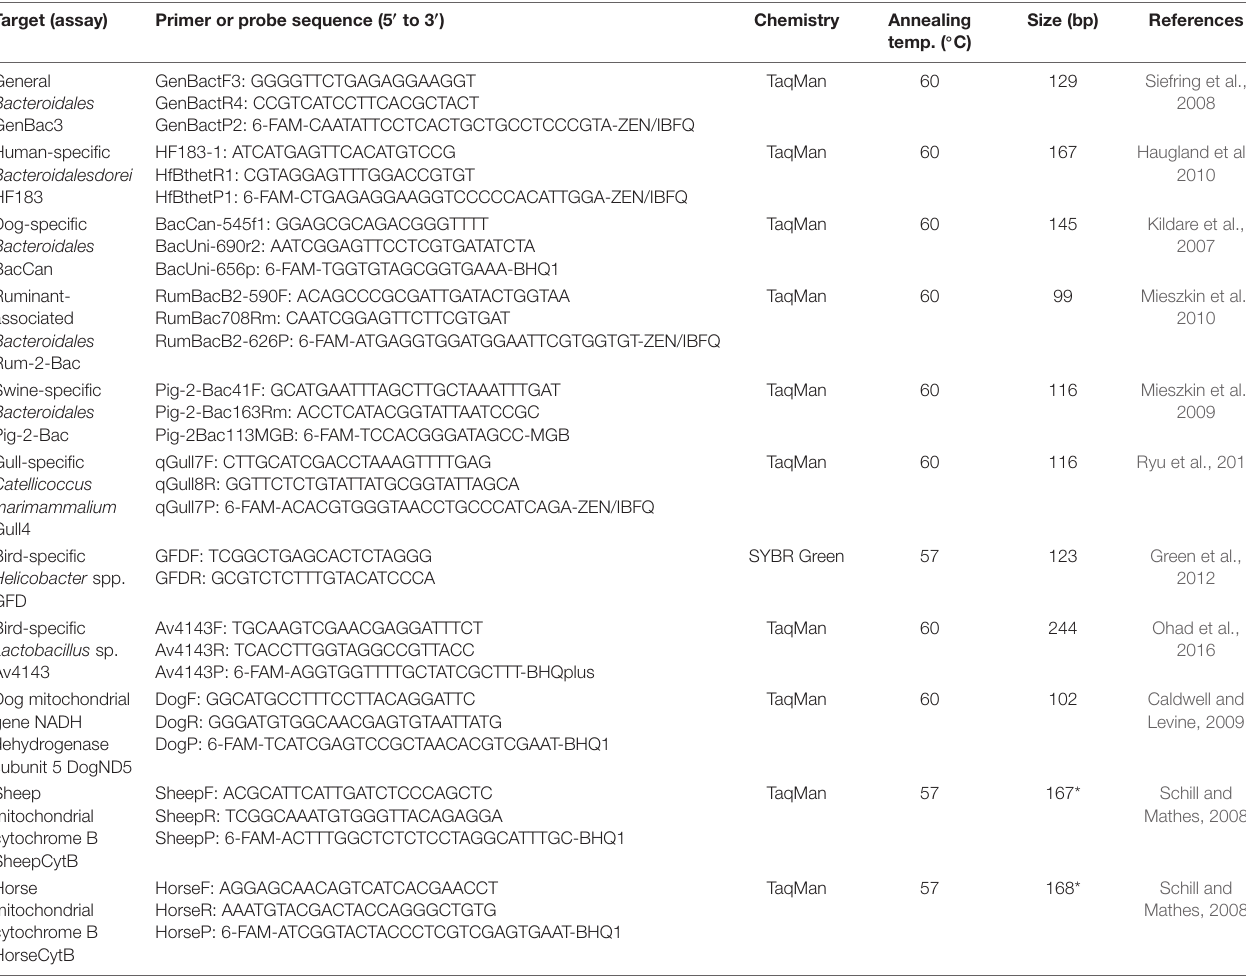
TABLE 2 | The qPCR-assays used in the study. Primer or probe sequence (5 (cid:48) to 3 (cid:48)